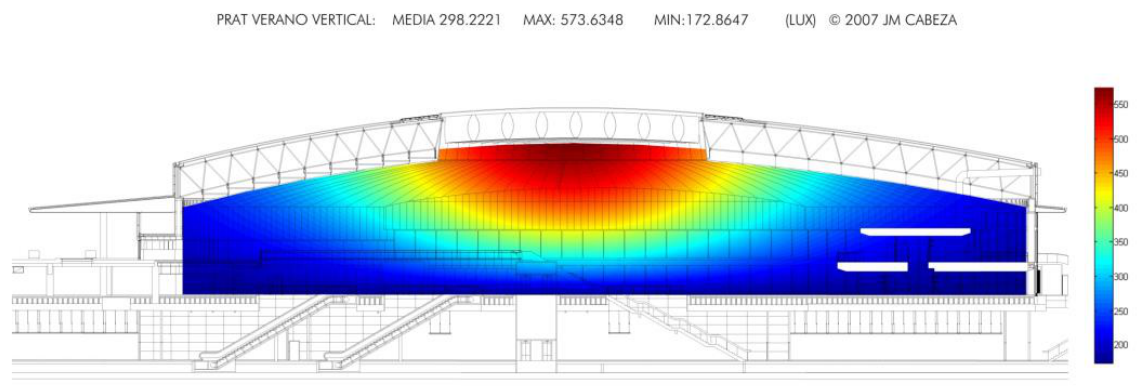
Figure 24. Distribution of radiation in summer in section. Values in Lux.